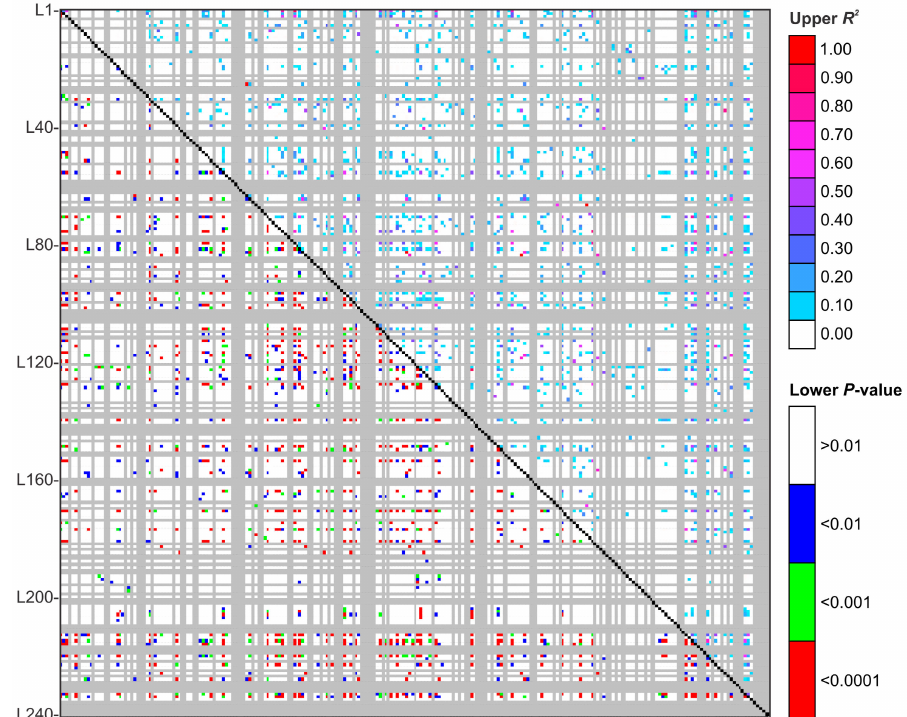
Figure 13. Marker-marker disequilibrium matrix for 240 polymorphic loci based on medically relevant Sporothrix species ( S. brasiliensis , n = 97; S. schenckii , n = 49; S. globosa , n = 34). Pairwise calculations (28,560 pairs) of linkage disequilibrium ( LD ) (r 2 ) are displayed above the diagonal, with the corresponding p -values for Fisher’s exact test shown below the diagonal. The locus position (L) is indicated on the left X-axis. The color legends indicate the level of significance ( p -value) and the corresponding strength of LD (r 2 ). Mean r 2 = 0.02714. Mean D (cid:48) =